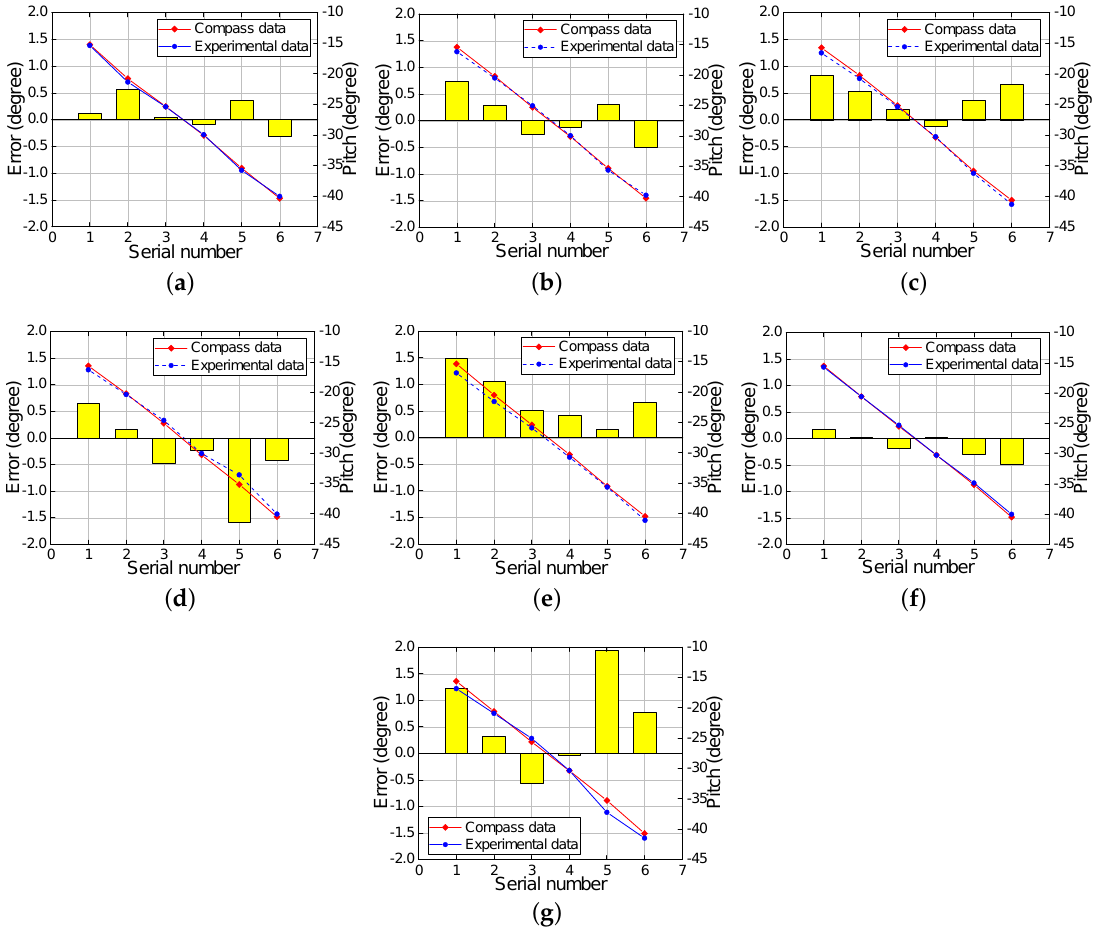
Figure 8. Pitch angle comparison at roll angles of ( a ) 0 ◦ ; ( b ) 5 ◦ ; ( c ) − 5 ◦ ; ( d ) 10 ◦ ; ( e ) − 10 ◦ ; ( f ) 15 ◦ ; and ( g ) − 15 ◦